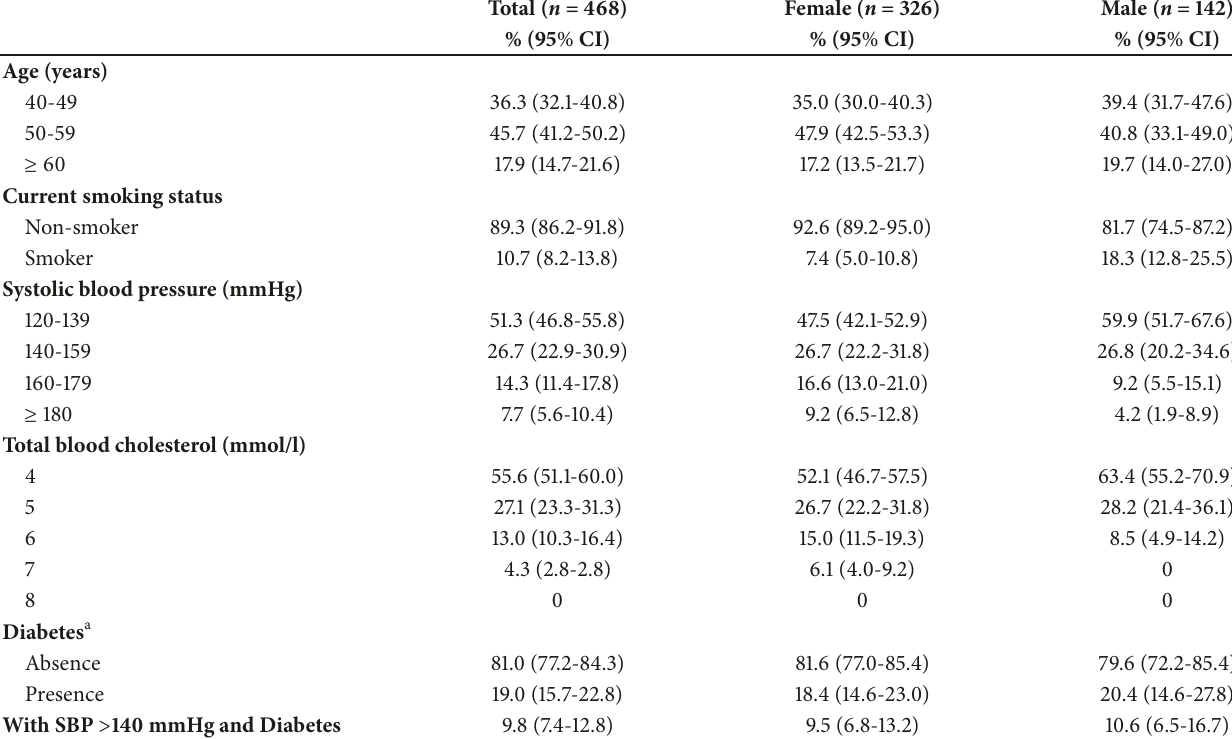
Table 1: Characteristics of the participants and prevalence by